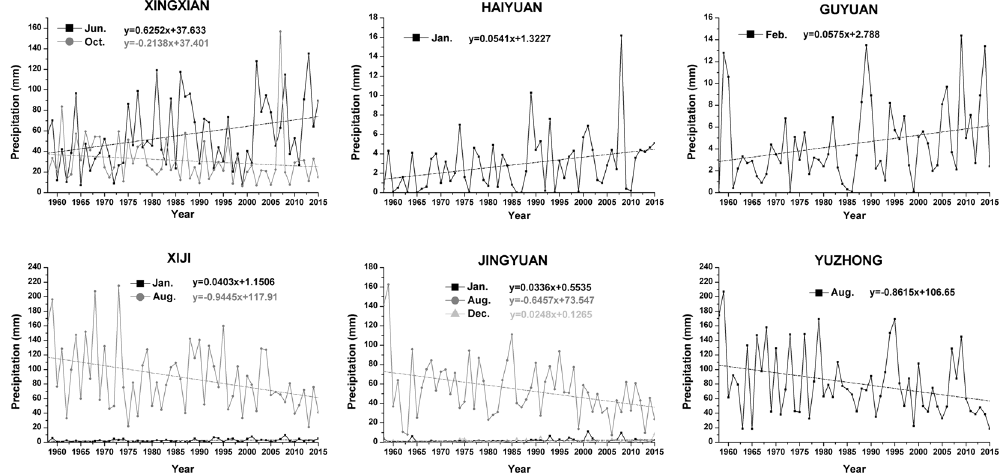
Figure 3. Variations in monthly precipitation at stations with significant trends during the study